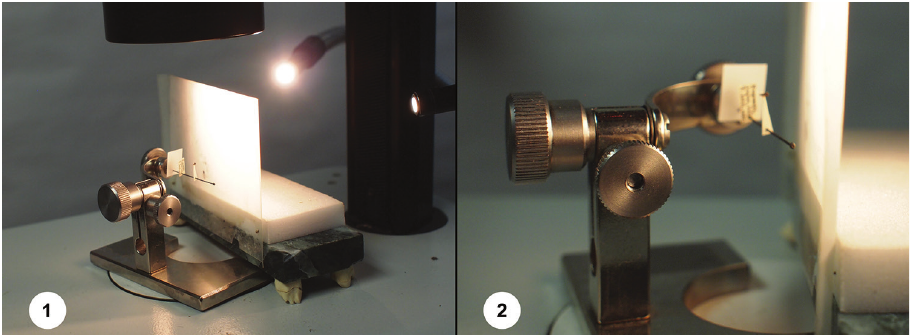
Figures 1–2. Configuration of mylar shield for reducing